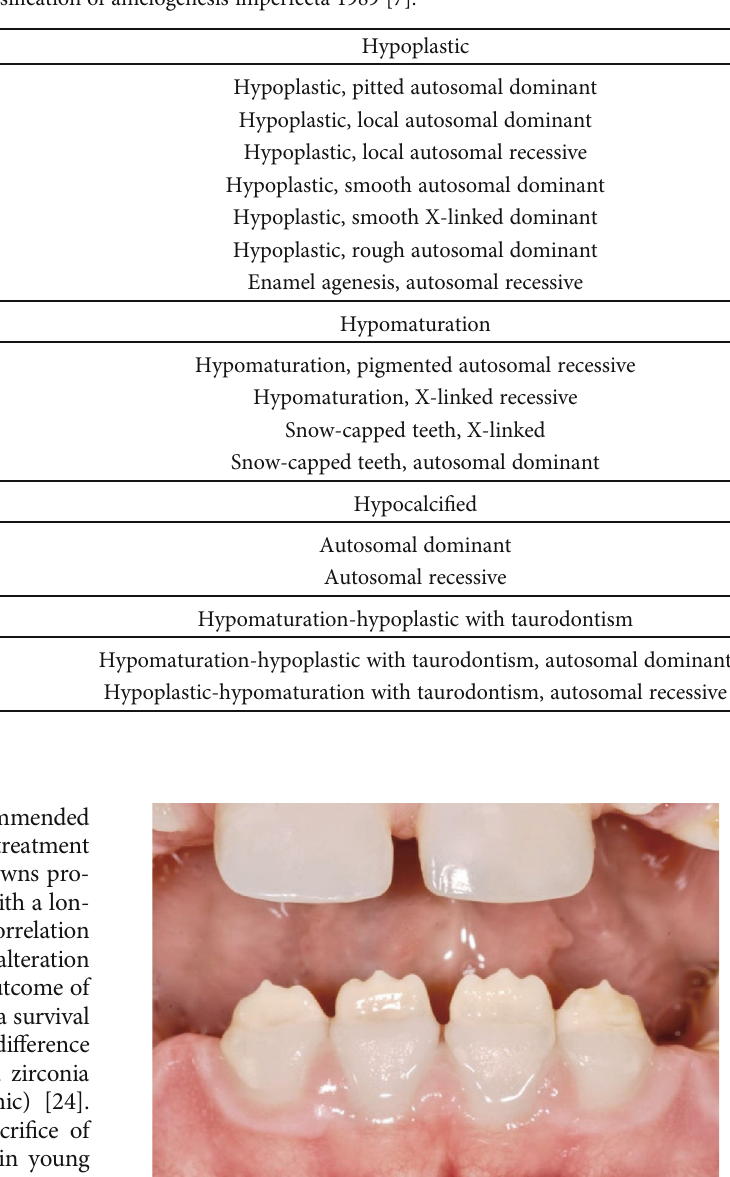
Table 1: Witkop classi fi cation of amelogenesis imperfecta 1989 [7].